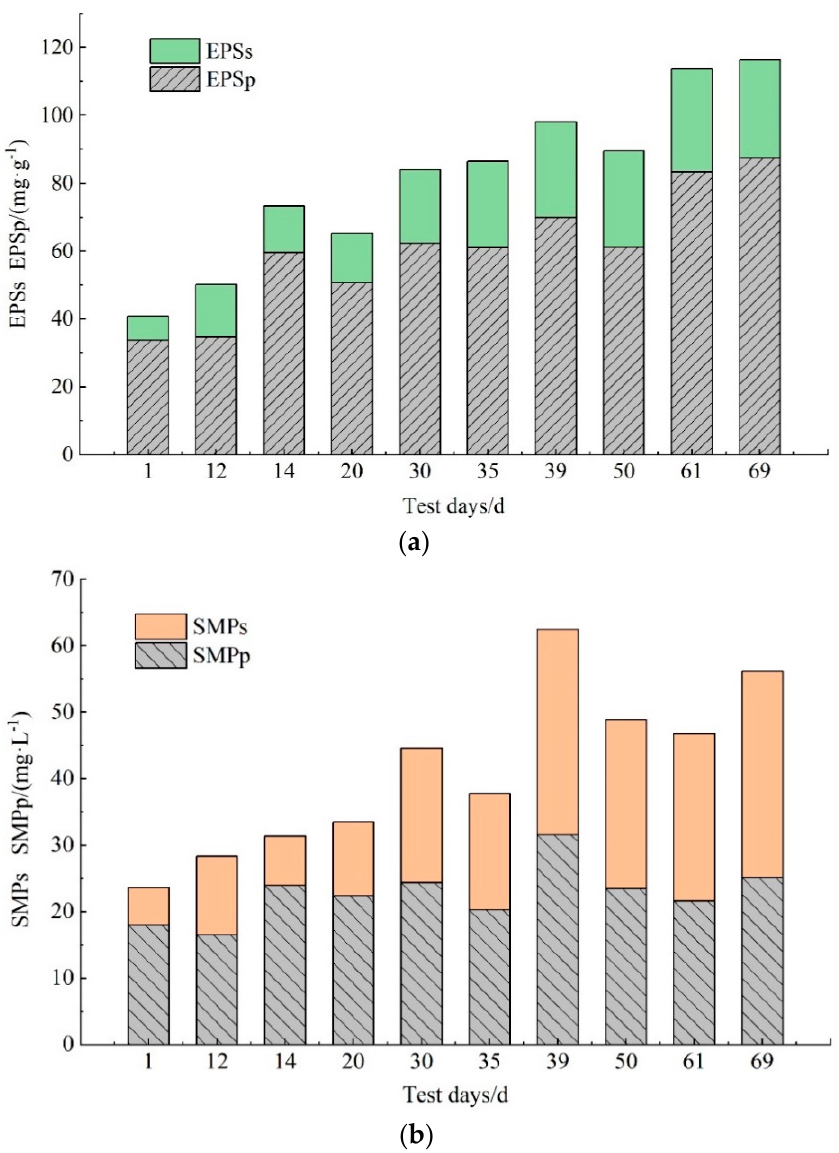
Figure 3. Changes in the content of polysaccharides and protein in ( a ) EPS and ( b ) SMP under different FA. EPSs, SMP S are polysaccharides and EPS P , SMP P are proteins, respectively.